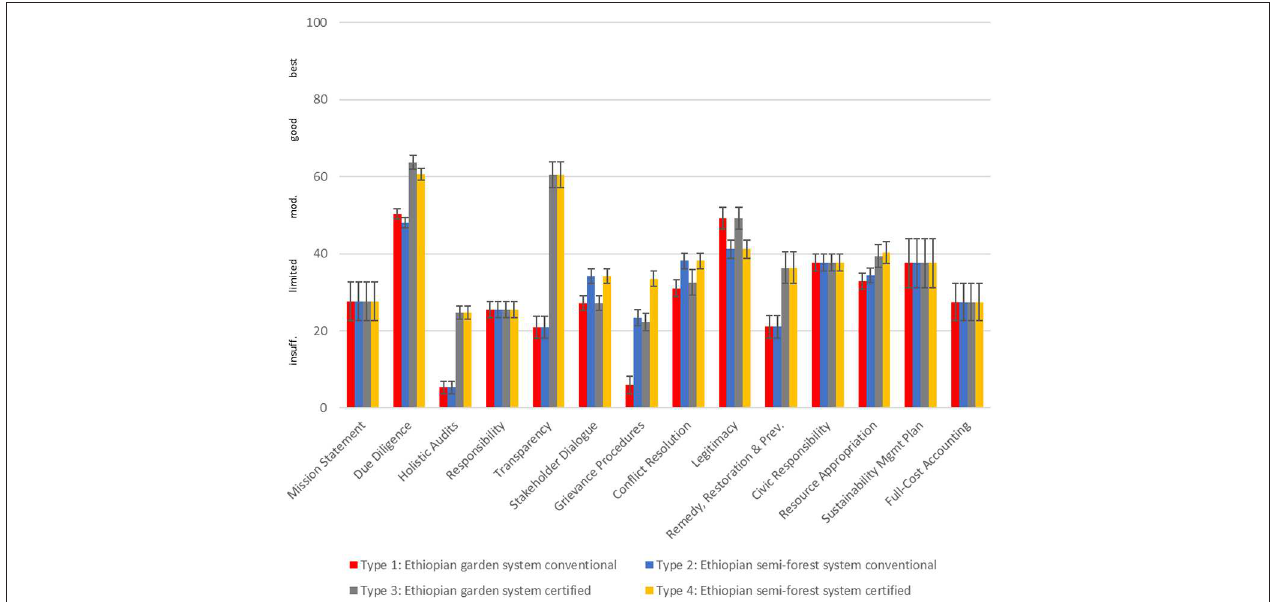
FIGURE 8 | Sustainability performance of typical Ethiopian coffee production systems in “Good Governance”.